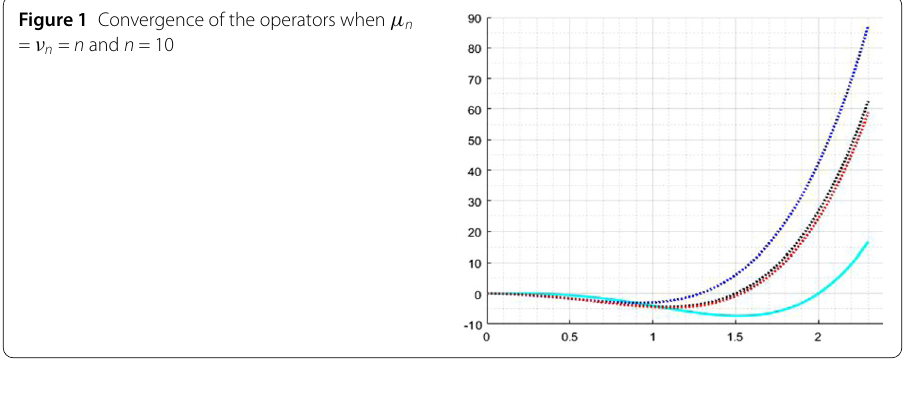
Figure 1 Convergence of the operators when μ n = ν n = n and n = 10